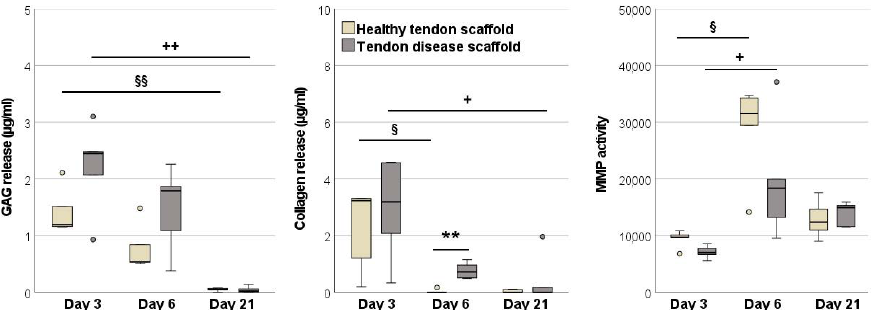
Figure 7. Glycosaminoglycan, total collagen, and matrix metalloproteinase (MMP) activity in the supernatants of healthy and diseased tendon scaffold cultures. Asterisks indicate significant differ- ences between groups with p < 0.01 (**). Significant differences over time are indicated by paragraph symbols for healthy tendon scaffold cultures and by plus symbols for diseased tendon scaffold cultures (§ or + for p < 0.05; §§ or ++ for p < 0.01). Data were obtained using scaffolds from n = 5 different tendons per